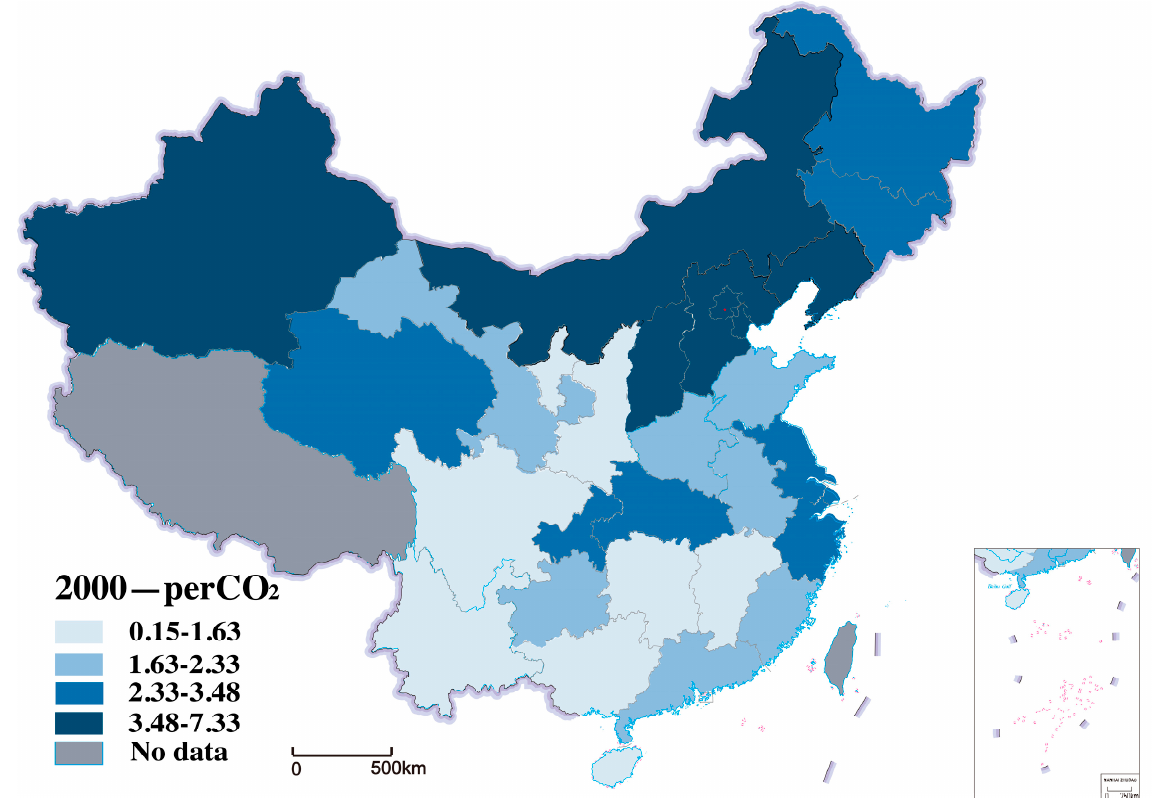
Figure 2. Distribution of carbon emissions per capita in 2000.